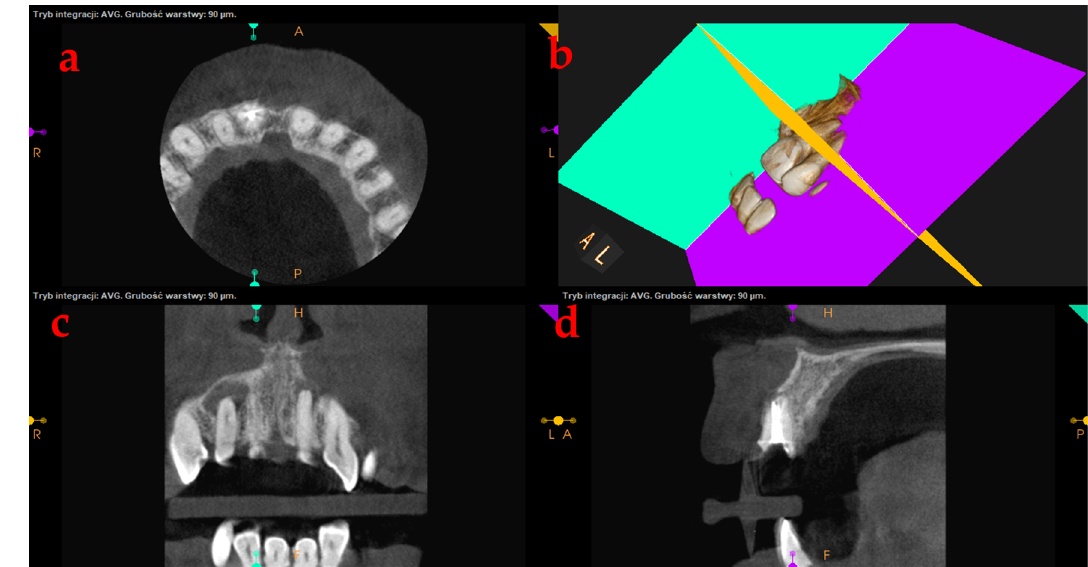
Figure 2. The procedure leading to the creation of a three-dimensional bone model is ( a ) a CT scan, axial tooth’s cross-sections, ( b ) a three-dimensional image of the bone structure and teeth; yellow: axial plane, green: longitudinal plane, pink: transverse plane, ( c ) tooth’s transverse cross-sections, and ( d ) tooth’s longitudinal cross-sections.